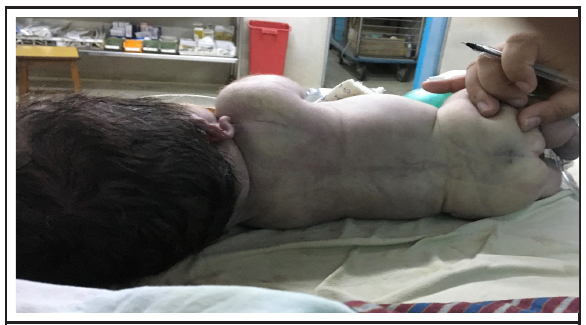
Figure 3. Showing flat back and spine with pit/ dimpling over the sacral